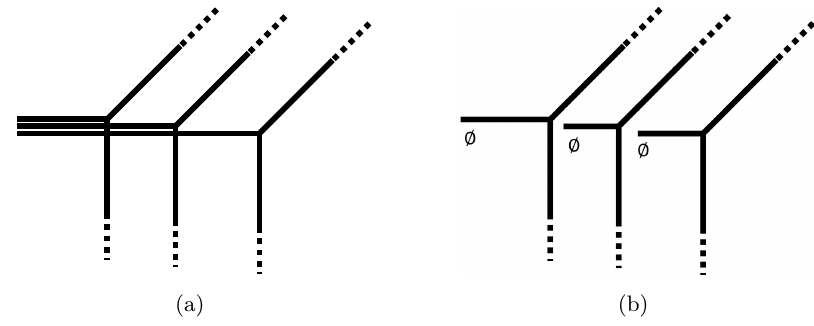
Figure 58. (a): A part of a non-toric web diagram. (b): The diagram which we used for applying the topological vertex to the diagram in figure 58(a).